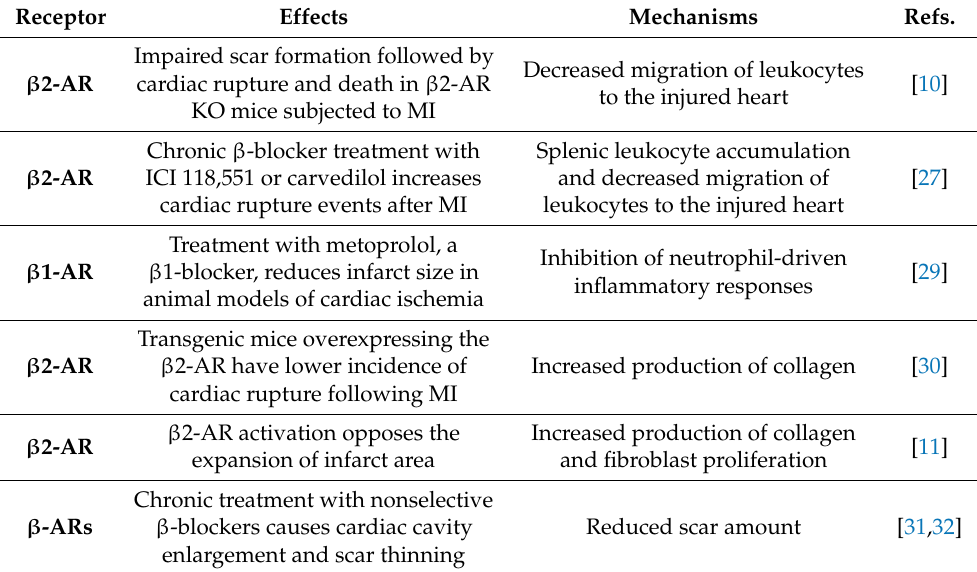
Table 2. β -ARs and cardiac repair following myocardial infarction in preclinical studies.